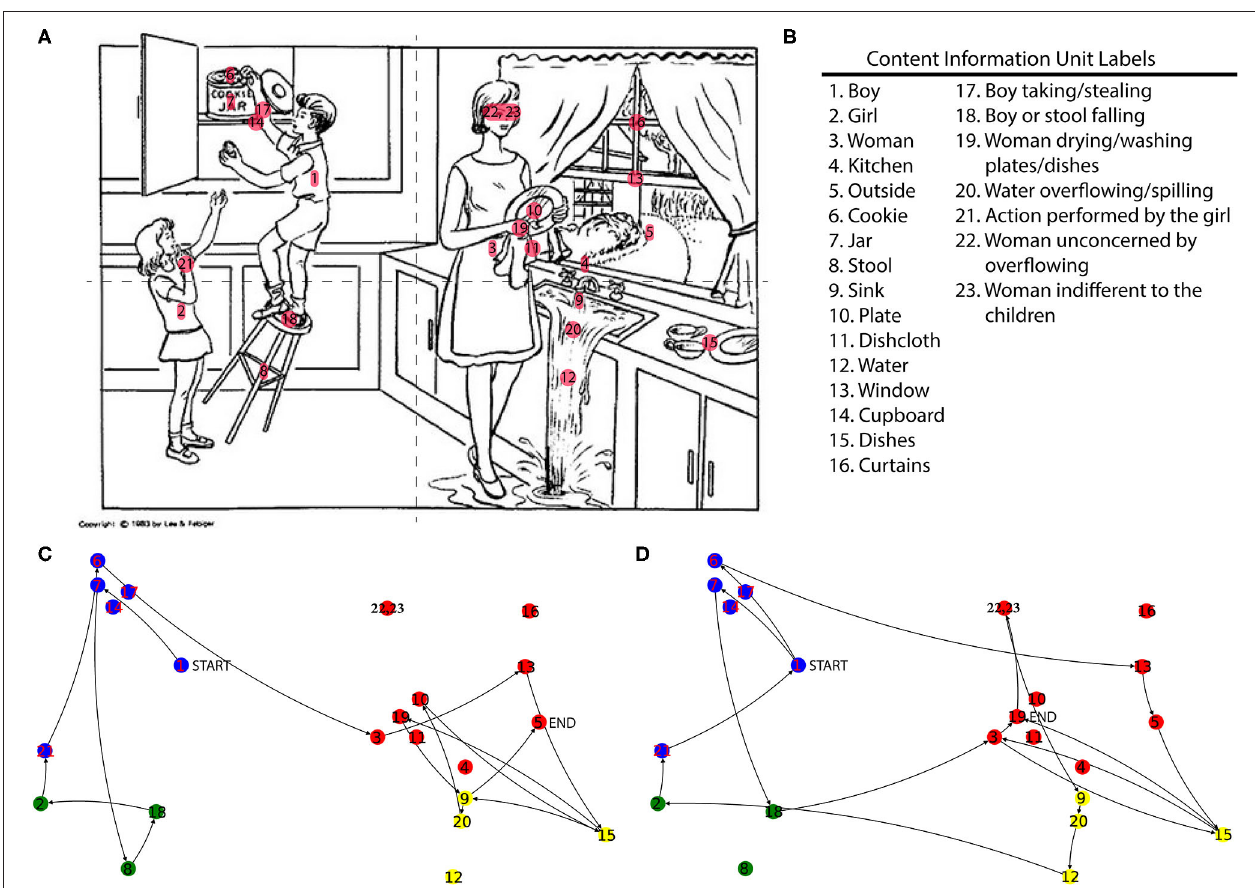
FIGURE 1 | (A) The image used in the cookie theft picture description task overlaid with the CIUs at their approximate assigned coordinate locations. Dotted lines indicate the quadrant splits in the image. (B) Definitions for the CIU labels. (C) Examples of a Healthy Control participant’s and (D) an AD participant’s descriptions transformed into spatio-semantic graphs. Nodes are labeled the same as in panel A and are colored according to quadrants in which nodes fall. Starting and ending nodes are labeled to the right of the corresponding nodes for both participants. While both participants reach the same number of unique nodes mentioned, the AD participant’s description has inefficient pathing with several repeats, cross quadrant transitions, and a larger total path distance traveled [(4), Used with